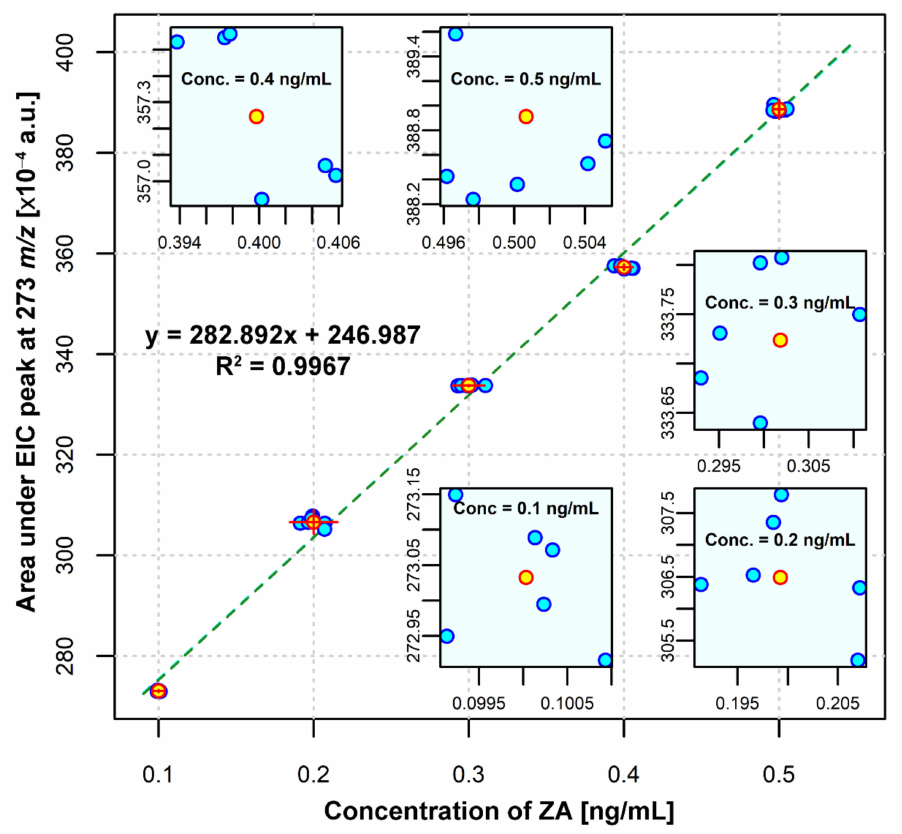
Figure 4. ZA calibration curve with Deming